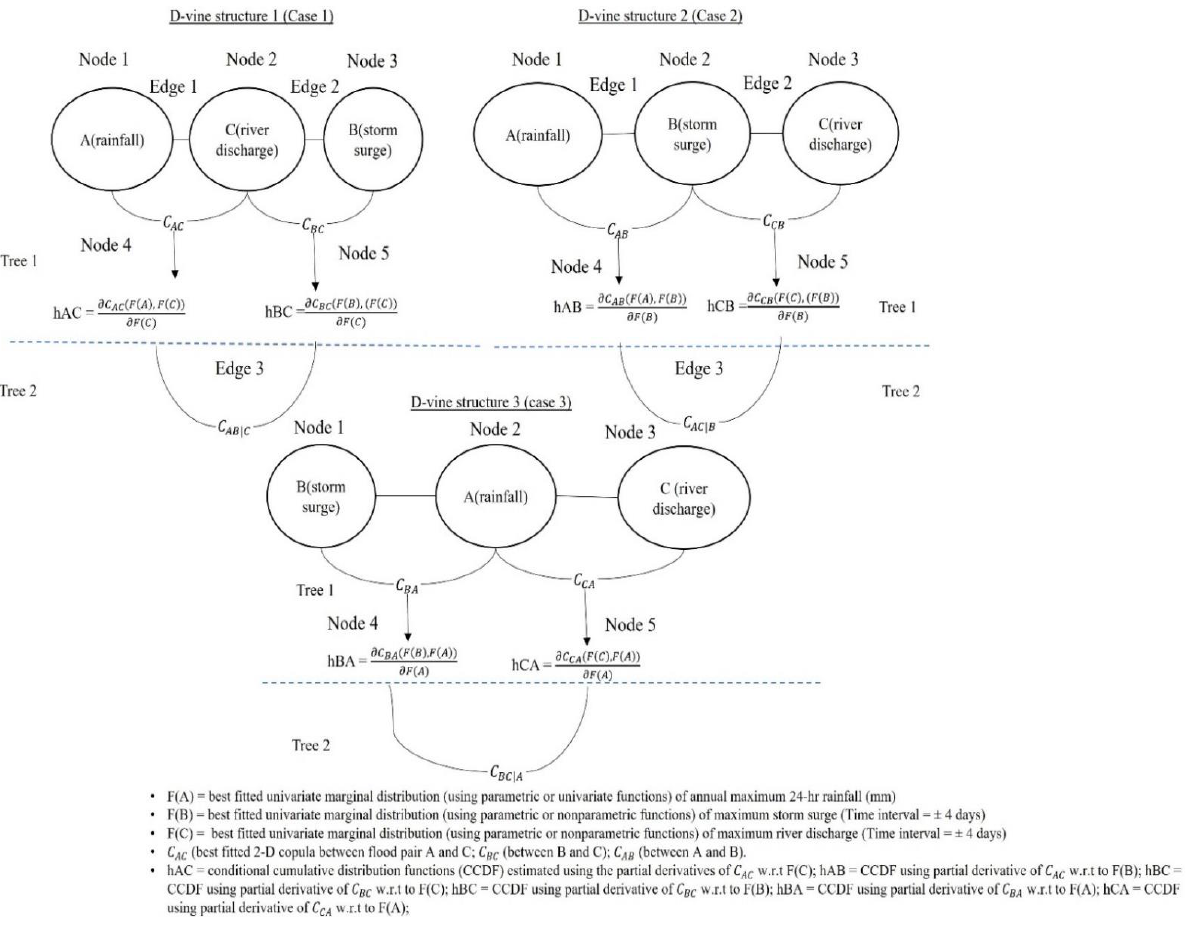
Figure 2. Schematic diagram in the 3-D D-vine copula simulation for three different cases [Note: each case of the D-vine structure is defined by permutating the location of the conditional variable, for instance, D-vine structure-1 (River discharge as conditioning variable), D-vine structure-2 (Storm surge as conditioning variable), D-vine structure-3 (Rainfall events as conditioning variable)].